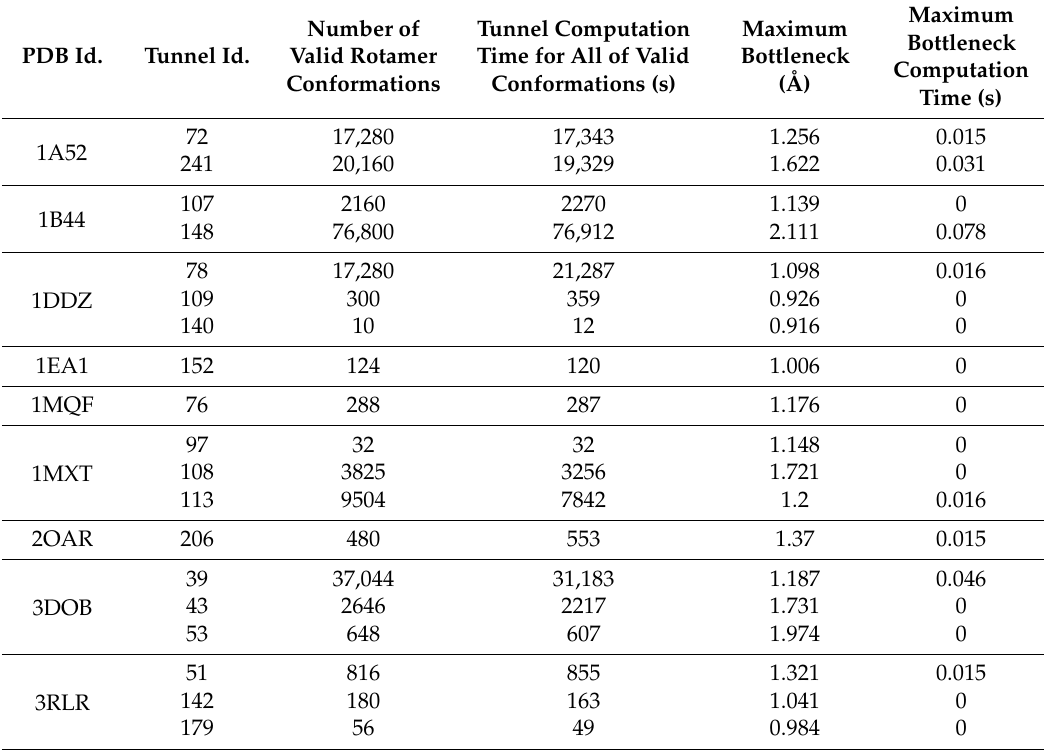
Table 2. Experimental Results on Finding the Maximum